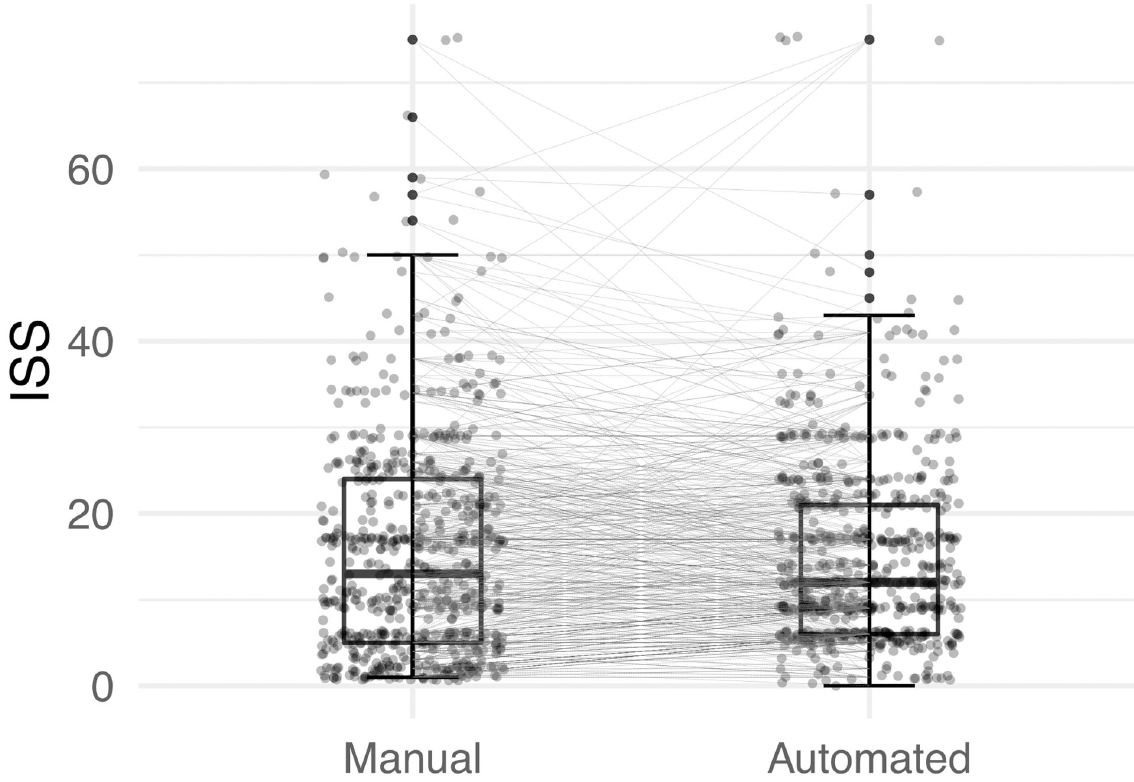
Fig 2. Boxplot with a median ISS of 13 (IQR 5, 24) by manual calculation and a median ISS of 12 (IQR 6, 21) by automated calculation. Each dot represents one measurement. Two measurements (one manually calculated, one automatically calculated) were available of each patient, which are graphically paired in this figure to visualise differences of the two ISS calculation methods. ISS = Injury Severity Score.